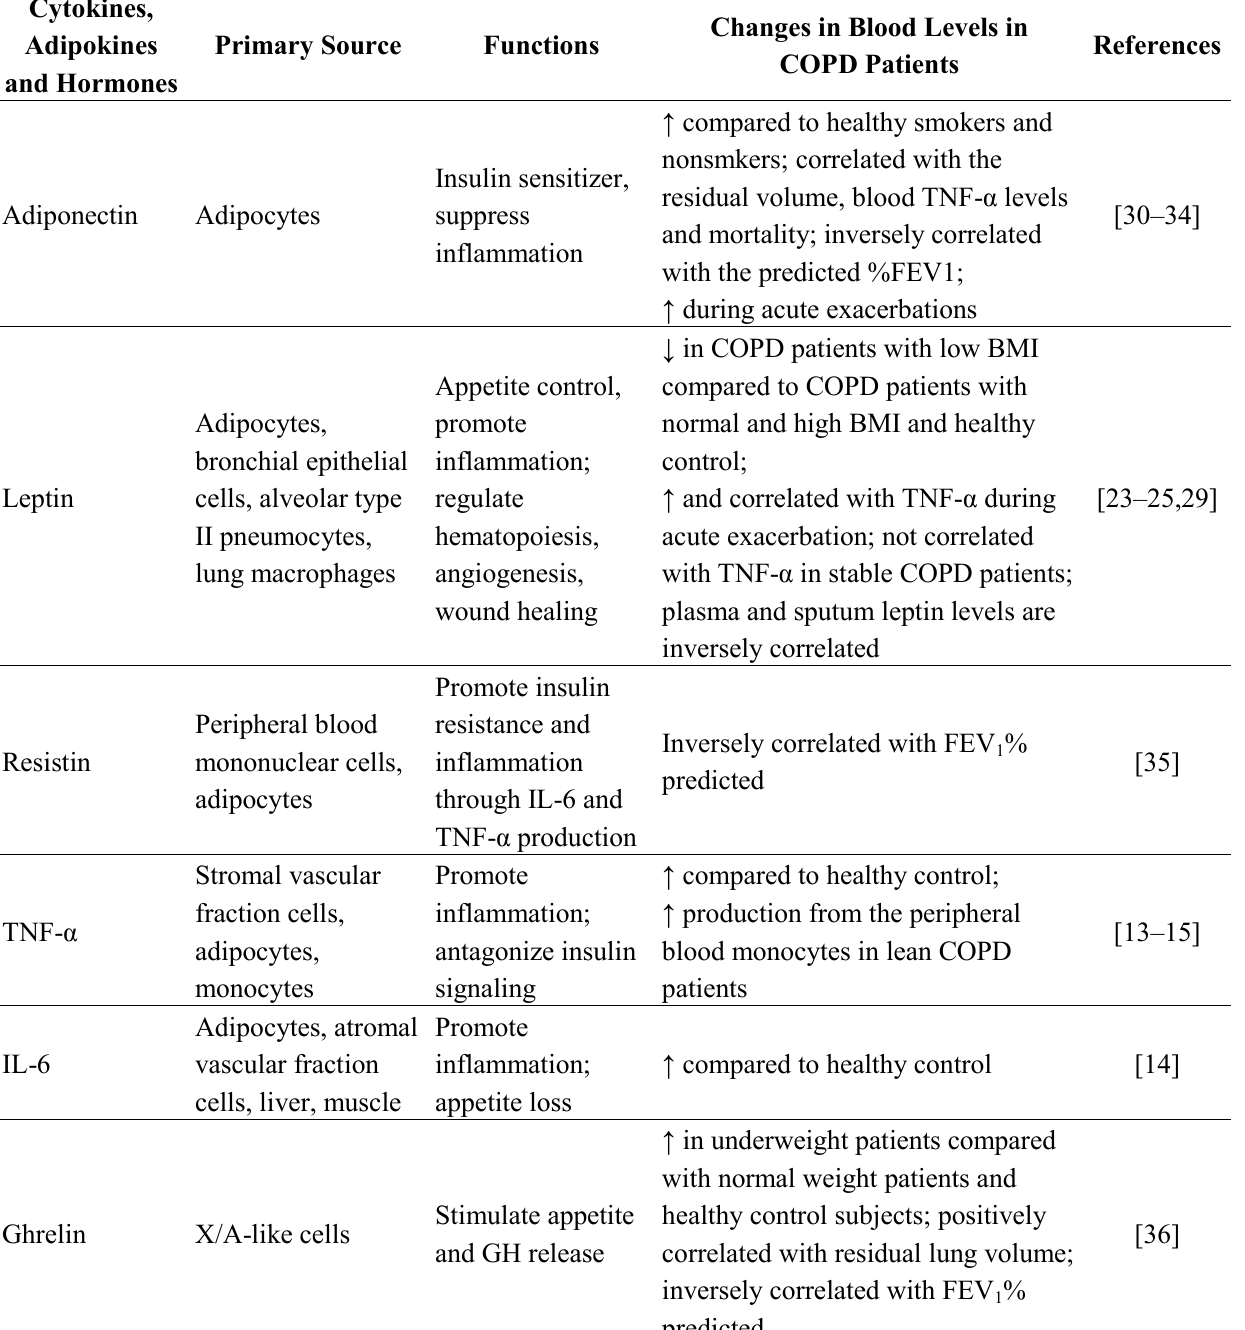
Table 1. Observed concentrations of the blood levels of inflammatory cytokines, adipokines and hormones in patients with chronic obstructive pulmonary disease (COPD).